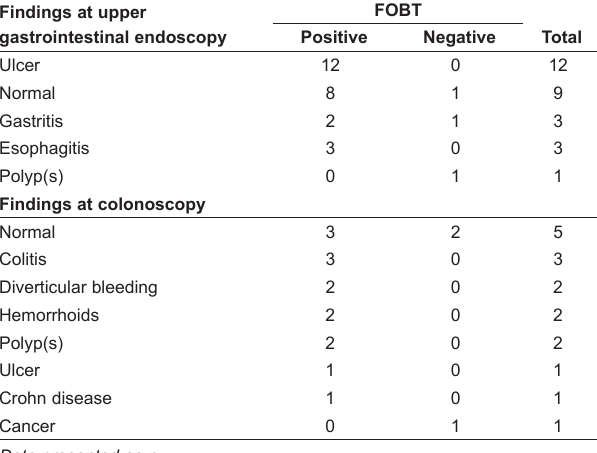
TAble 2 Findings at endoscopy for patients referred after